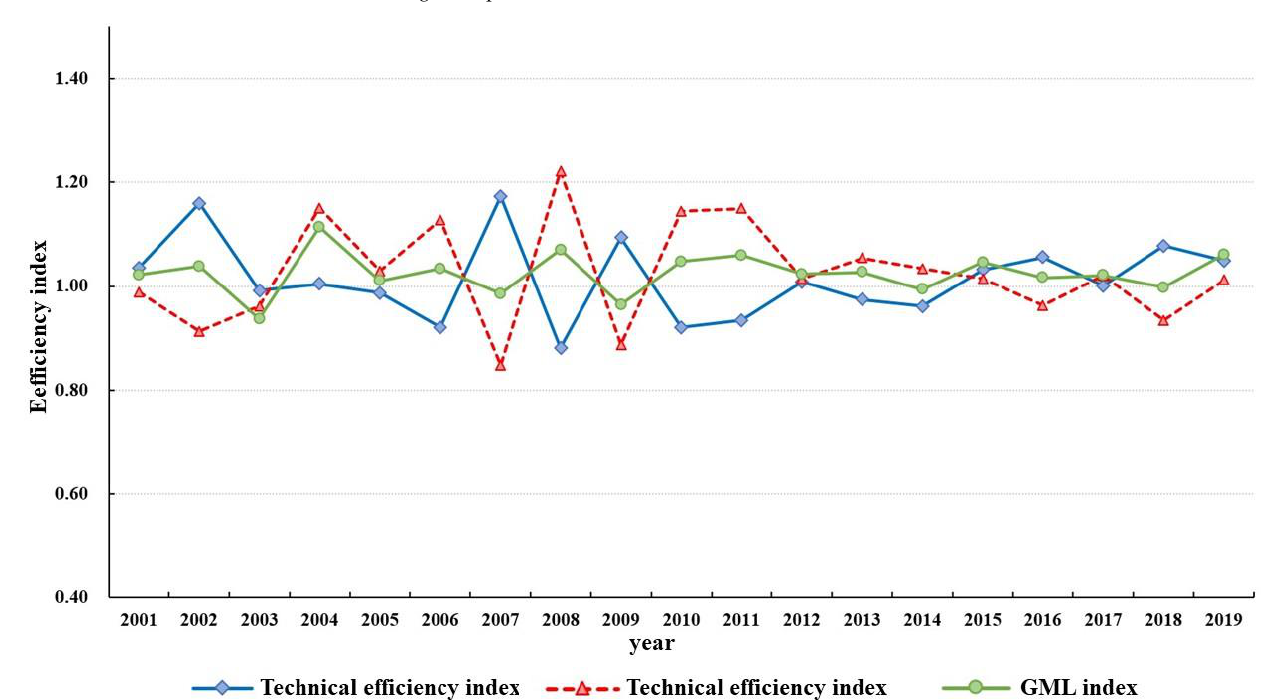
Figure 8. The change index and decomposition index trend of total factor productivity of grain production resources in major grain-producing areas from 2000 to 2019 after adjustment.